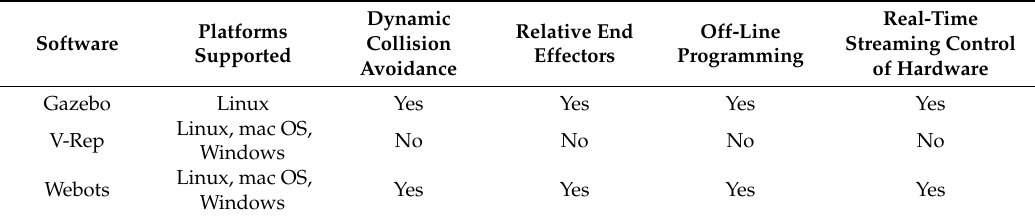
Table 1. Features of various robot simulator software.